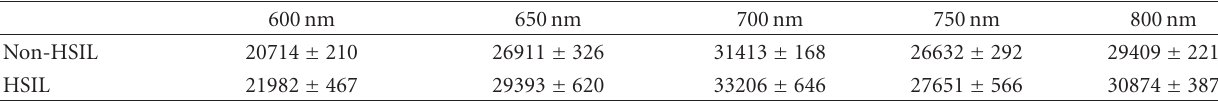
Table 2: Relative intensity of HSIL and non-HSIL